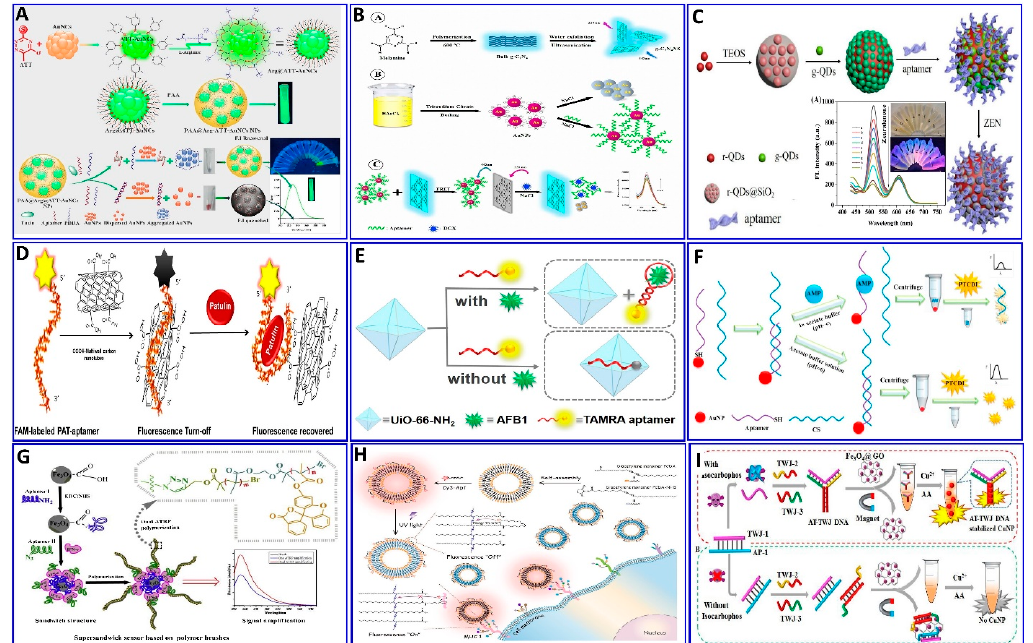
Figure 6. ( A ) Schematics showing the preparation of PAA@Arg@ATT-AuNC as a fluorescent probe for trichothecenes A (T-2) toxin assay, reproduced from [119]. ( B ) Graphical illustration for the assaying of digoxin (DGX) using the aptamer/AuNPs/g-C3N4NS sensor probe, reproduced from [120]. ( C ) Schematic illustration of the zearalenone assay using a ratiometric fluorescent nanoprobe with dual emission at 518 and 608 nm, reproduced from [121]. ( D ) Schematic description of the protocol employed for a patulin (PAT) assay via CA-MWCNTs) with quenching of aptamer-tagged carboxyfluorescein, reproduced from [130]. ( E ) Schematic description of AFB1 detection based on UiO-66-NH 2 and aptamer-functionalized TAMRA dye, reproduced from [123]. ( F ) Schematic of the fluorescent aptasensor for an AMP assay based on the competitive quenching between the AMP aptamer complementary strand and AuNPs, reproduced from [131]. ( G ) Schematic showing an ultrasensitive fluorometric aptasensor for IFN- γ detection by dual atom transfer radical